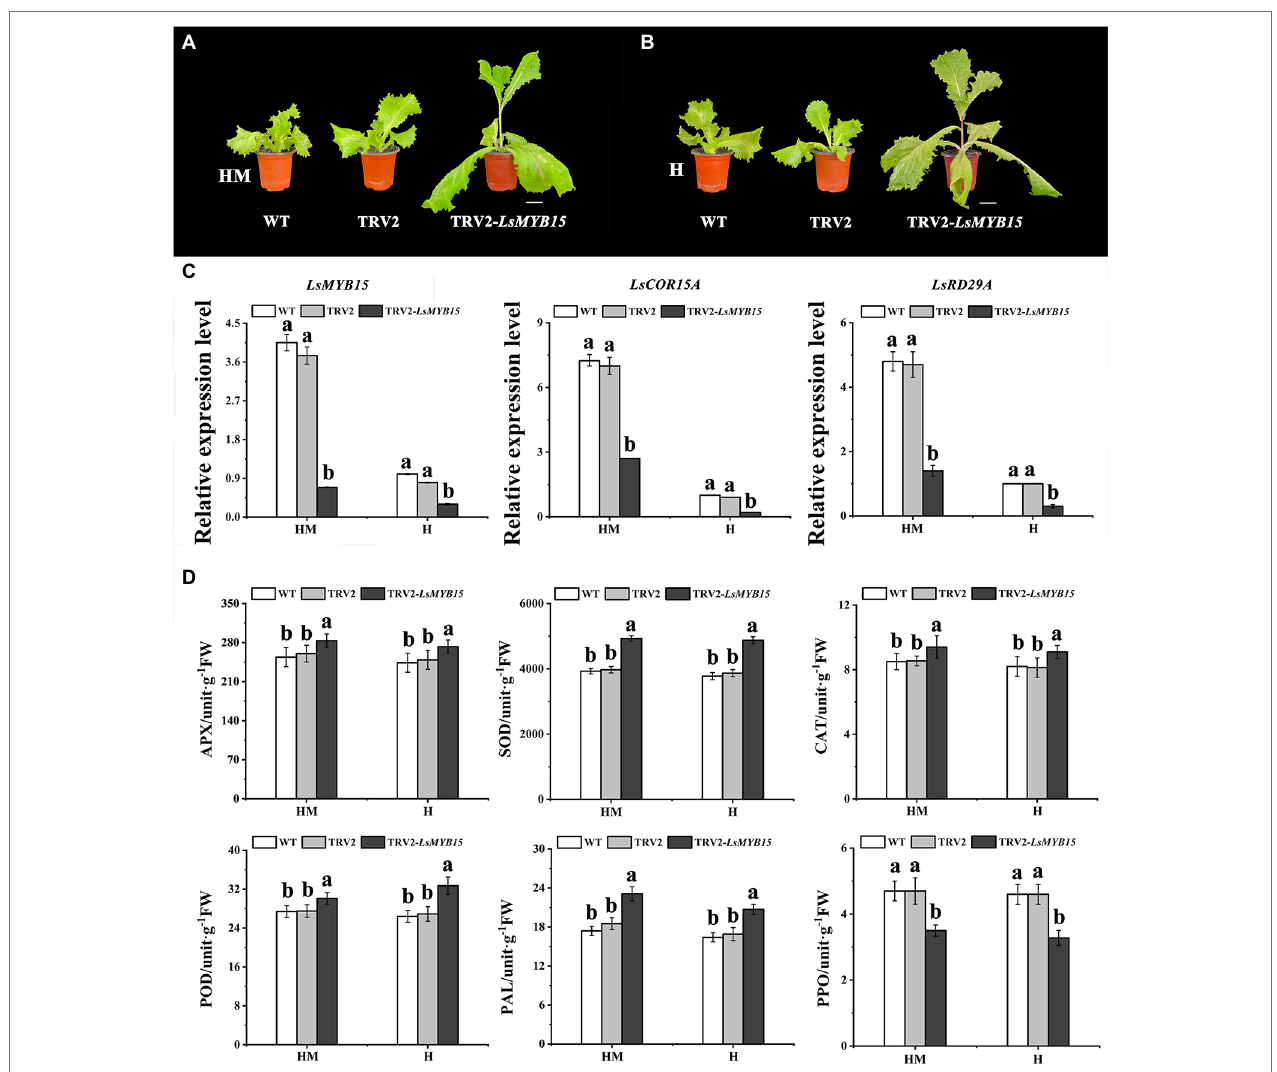
FIGURE 6 | Silencing of LsMYB15 genes in the bolting-sensitive line S39. (A) Under high-temperature conditions, the exogenous melatonin administration constructs developed a bolting phenotype 7 days postinfection. Scale bars = 5 cm. (B) Under high-temperature conditions, the control group that did not have exogenous melatonin construct developed a bolting phenotype 7 days postinfection. Scale bars = 5 cm. (C) Relative expression levels in inoculated TRV2- LsMYB15 plants were determined using qRT-PCR to determine transcription levels of three genes ( LsMYB15 , LsCOR15A , and LsRD29A ) in leaf lettuce plants. (D) Activities of APX, SOD, CAT, POD, PAL, and PPO during heat treatment of control and melatonin-treated leaf lettuce. Bars indicate the standard error from each mean of three independent replications. Mean values with the same letter are not significantly different ( p < 0.05). An increase in absorbance of 0.01 at 290 nm, 0.01 at 560 nm, 0.01 at 240 nm, 0.01 at 450 nm, 0.01 at 290 nm and 0.001 at 420 nm per min was defined as one unit (U) of APX, SOD, CAT, POD, PAL, and PPO activity, respectively. “MH” represents 100 μ mol L − 1 melatonin treatment under high temperature, and “H” represents no exogenous melatonin treatment under high temperature. Error bars indicate the SEM of three replicate measurements. Different letters above the bars indicate significantly different values ( p < 0.05) calculated using one-way analysis of variance (ANOVA) followed by Tukey’s multiple range